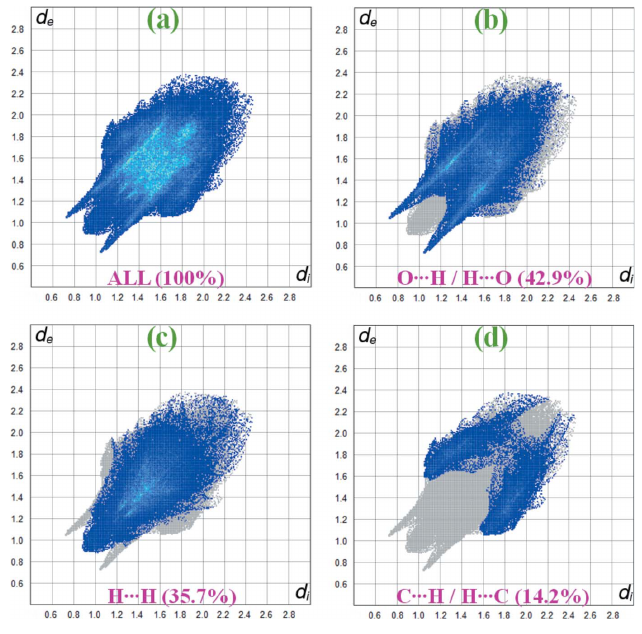
(cid:5) y , 1 + z ; (ii) x , (cid:5) y , 1 + z ; (iii) 1 + x , 1 + z ]. 2 2 2 2 2